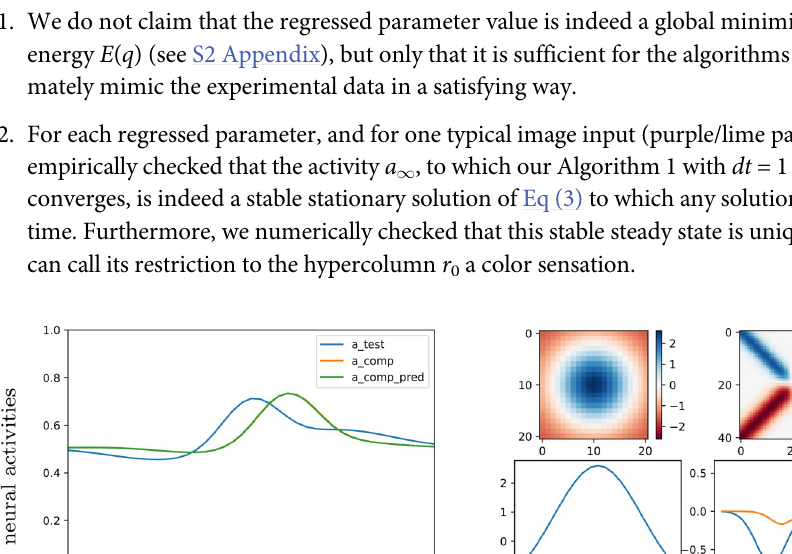
coordinates with c = s − 1 . The opp